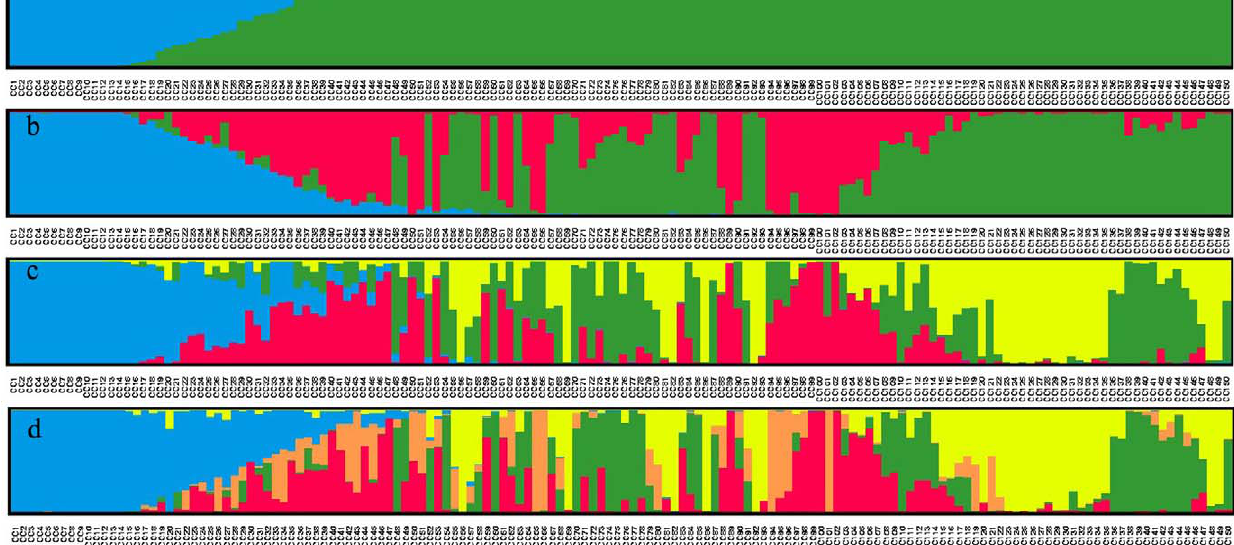
Table 2. Distribution of the rice varieties in the entire collection, subgroups, and sub-subgroups identified by STRUCTURE.